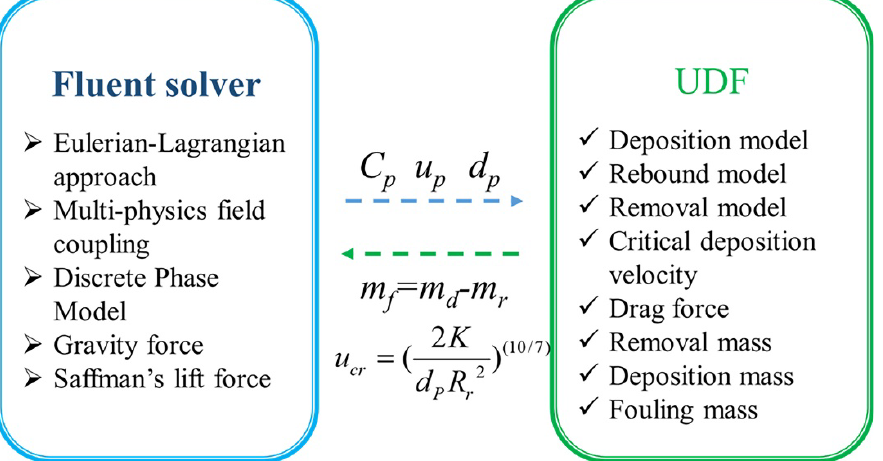
Figure 6. Numerical procedure for fouling model.